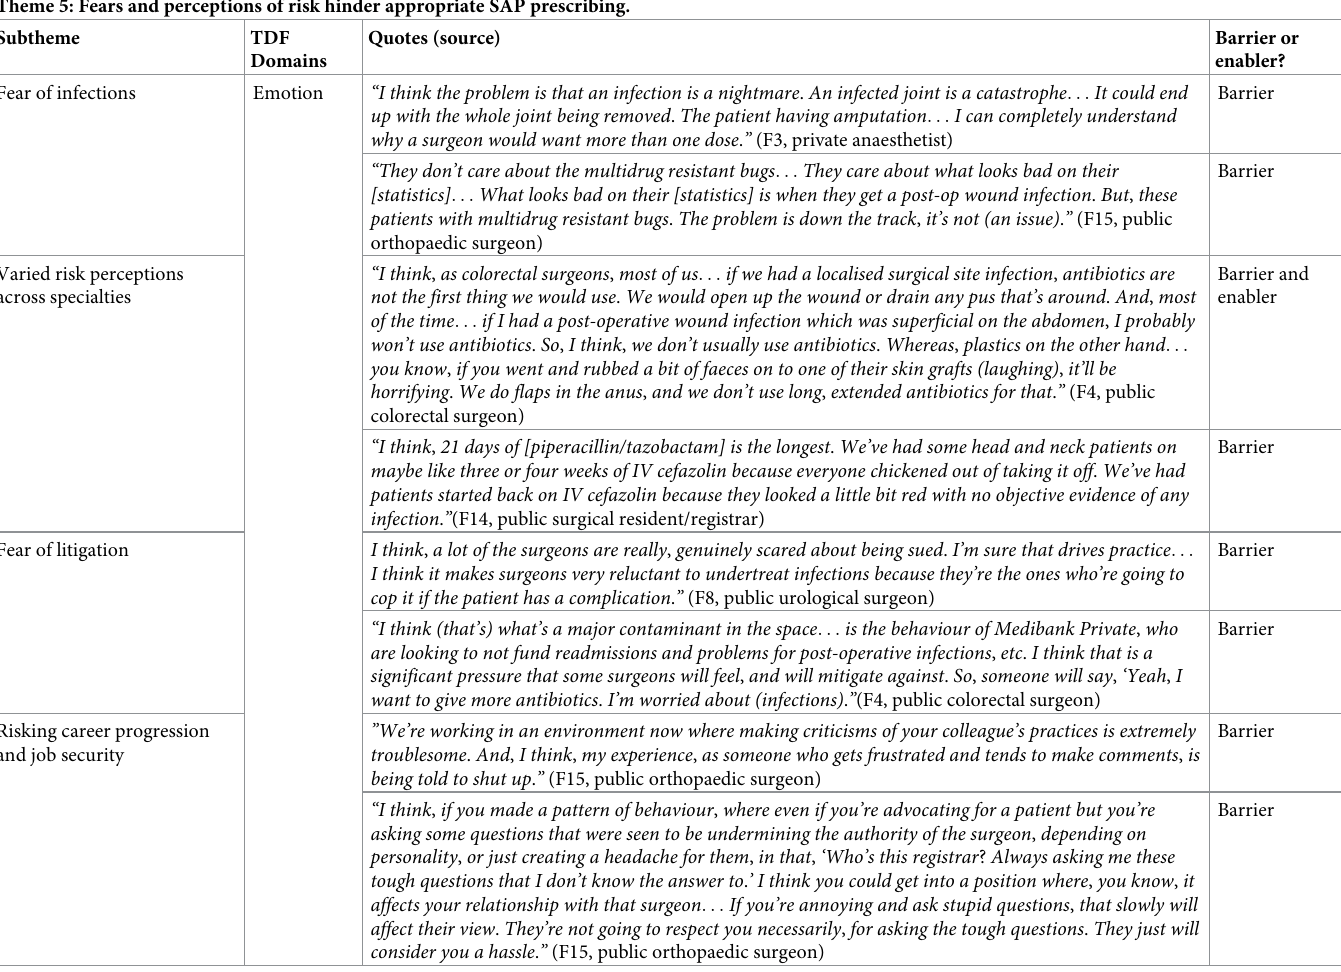
Table 7. Representative quotations from Theme 5 reflecting ‘Automatic Motivation’ of the COM-B model. Theme 5: Fears and perceptions of risk hinder appropriate SAP